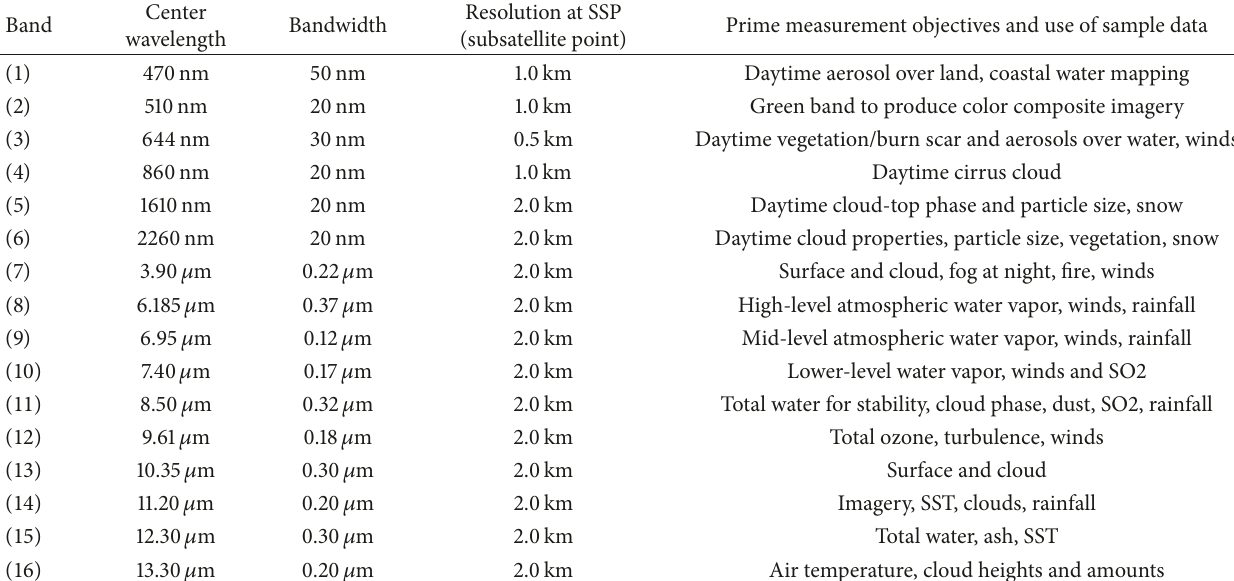
Table 1: Characteristics of the Himawari-8 AHI instrument.